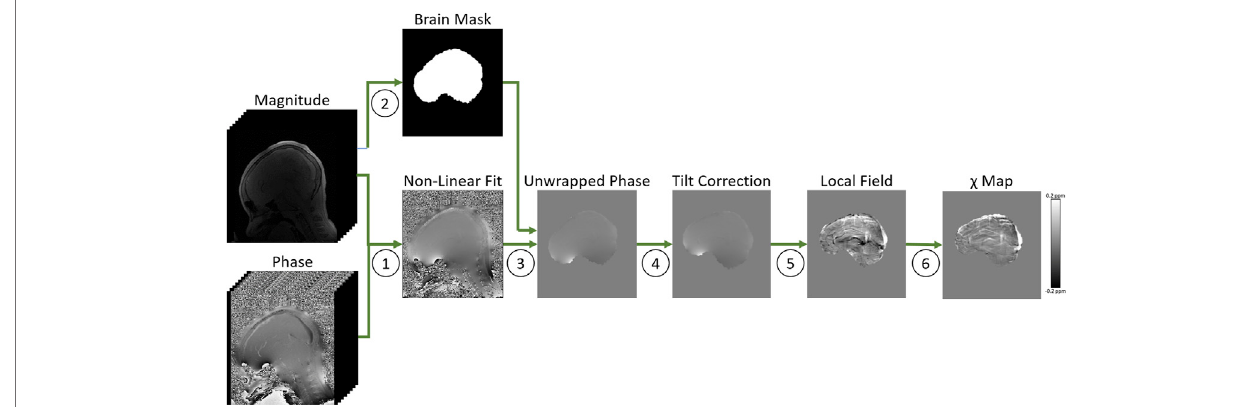
FIGURE 1 | Overview of the quantitative susceptibility mapping processing pipeline in a representative healthy control, applied to the MPM T1-weighted FLASH sequence. 1. Total fi eld maps were estimated from a non-linear fi t of the complex multi-echo images (Liu et al., 2013). 2. Brain masks were estimated using FSL brain extractiontool(Smith2002).3.Residualwrapsinthe fi eldmapwereremovedusingSEGUEphaseunwrapping(KarsaandShmueli2018).4.Imageswererealignedwith the B 0 direction (Kiersnowski et al., 2021). 5. Background fi eld removal was performed using projection onto dipole fi elds (Liu et al., 2011) 6. Susceptibility maps were calculated using an iterative Tikhonov method (Karsa et al.